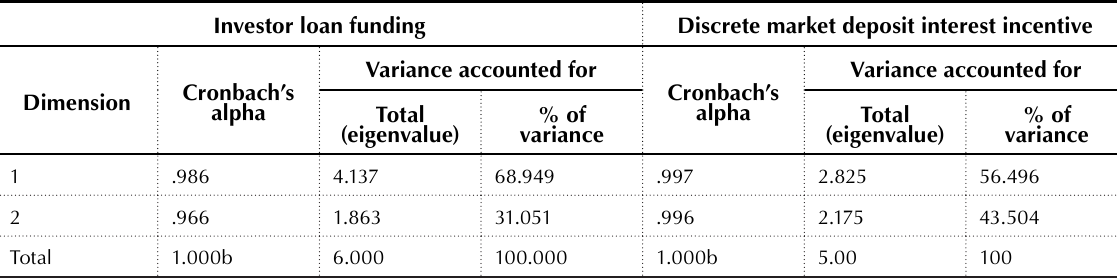
Table 13. Model summary rotation a